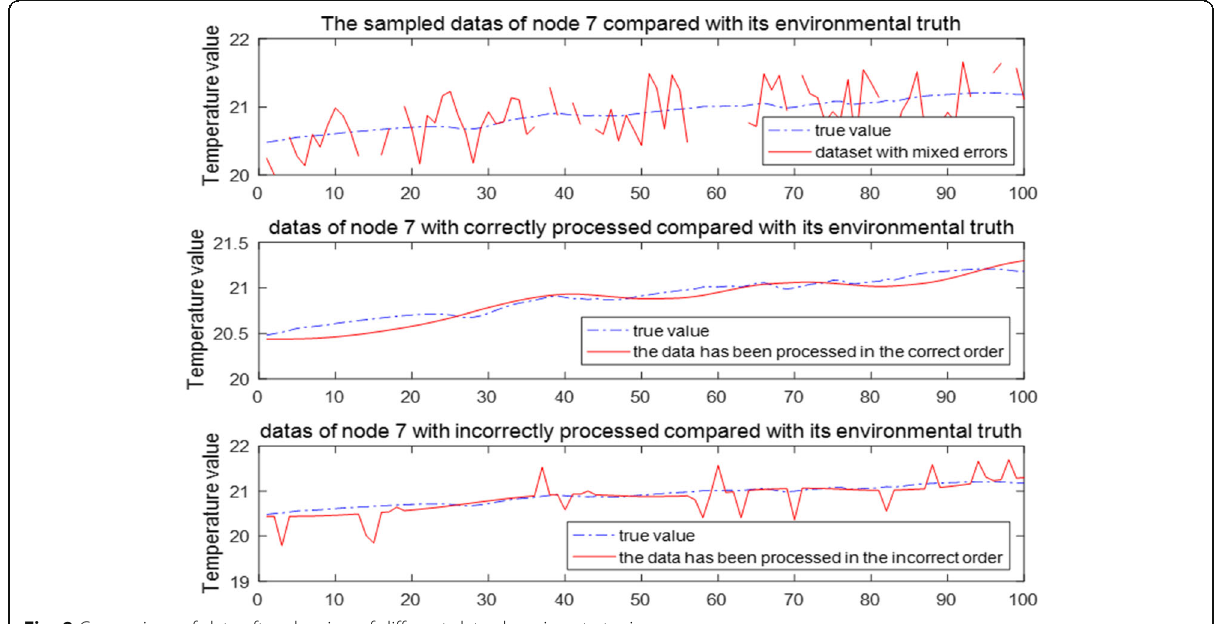
Fig. 8 Comparison of data after cleaning of different data cleansing